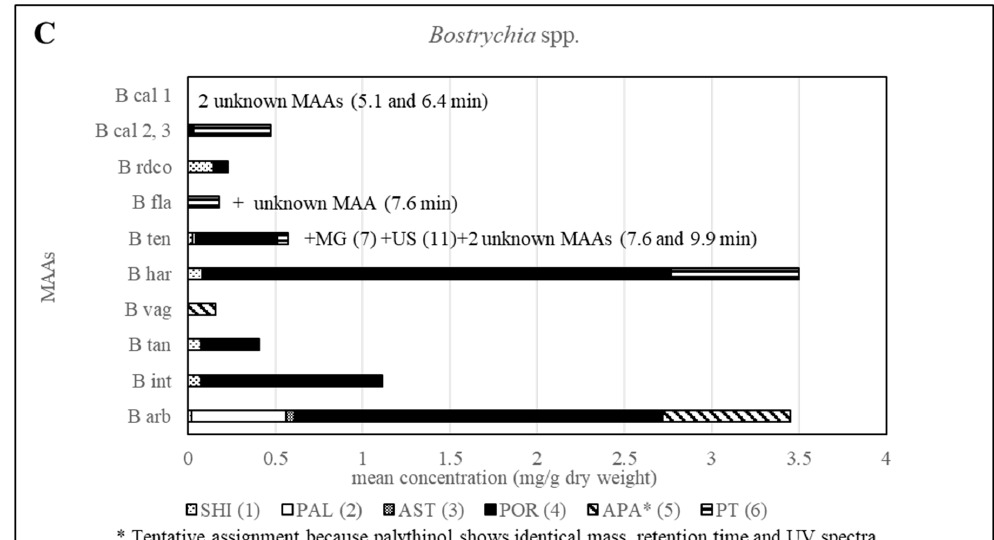
Figure 6. Overview of the content of MAAs expressed as mean value in mg per g of dry material for various Bostrychia species. Assignment of the species: B arb, B. arbuscula ; B int, B. intricata ; B tan, B. tangatensis ; B vag, B. vaga ; B har, B. harveyi ; B ten, B. tenella ; B fla, B. flagellifera ; B cal, B. calliptera ; B rdco, B. radicosa .